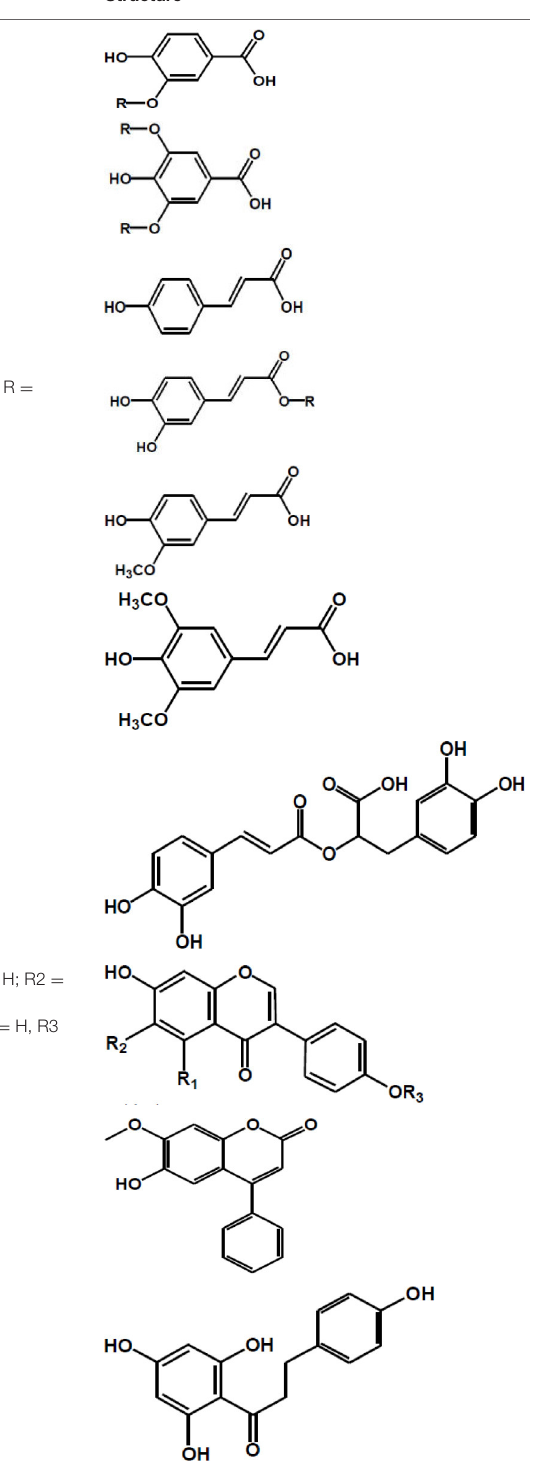
TABLE 2 | Chemical structure of some common dietary polyphenols. Dietary polyphenol